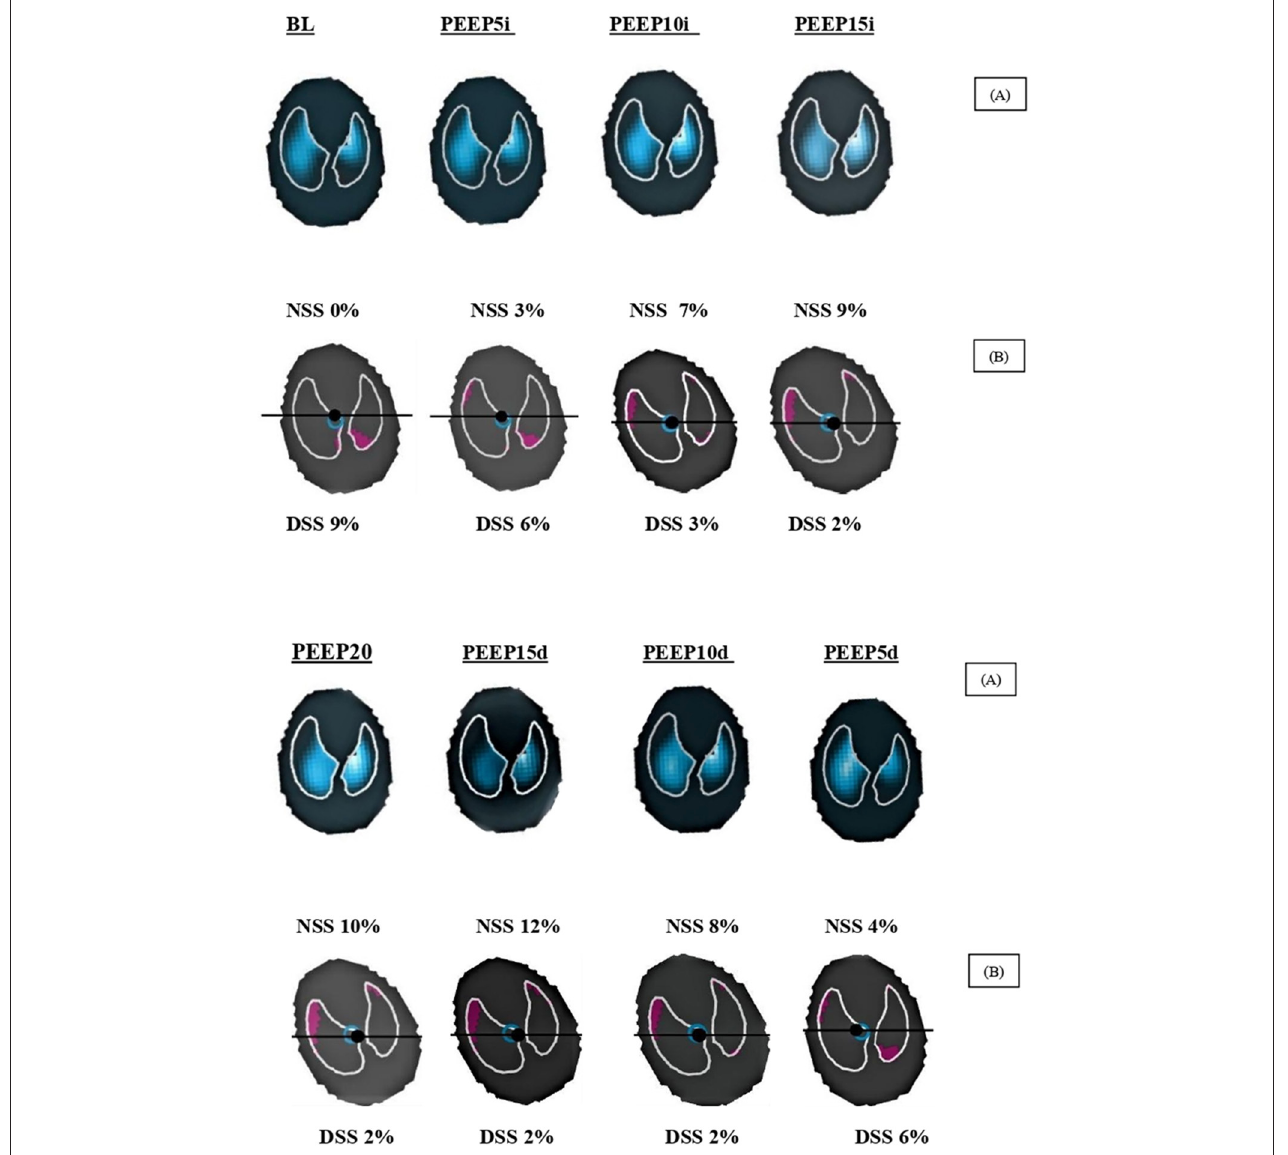
FIGURE 3 | Regional impedance variation and DSS and NSS values of a representative dog during recruitment maneuver for PEEP titration. NSS, nondependent silent space; DSS, dependent silent space; BL, baseline; PEEP5i, PEEP 5 cmH 2 O increase; PEEP10i, PEEP 10 cmH 2 O increase; PEEP15i, PEEP 15 cmH 2 O increase; PEEP20i, PEEP 20 cmH 2 O increase; PEEP15d, PEEP 15 cmH 2 O decrease; PEEP10d, PEEP 10 cmH 2 O decrease; PEEP5d, PEEP 5 cmH 2 O decrease. (A) Tidal ventilation within the region of interest. The impedance changes ( 1 Z) are larger in more light blue regions and the impedance changes are lower in more black regions. (B) SS is visualized as pink areas within the region of interest. The black line shows the ventilation horizon and the black dot represents the CoV. When increasing PEEP steps, the DSS decreased, and NSS increased, but the opposite was also